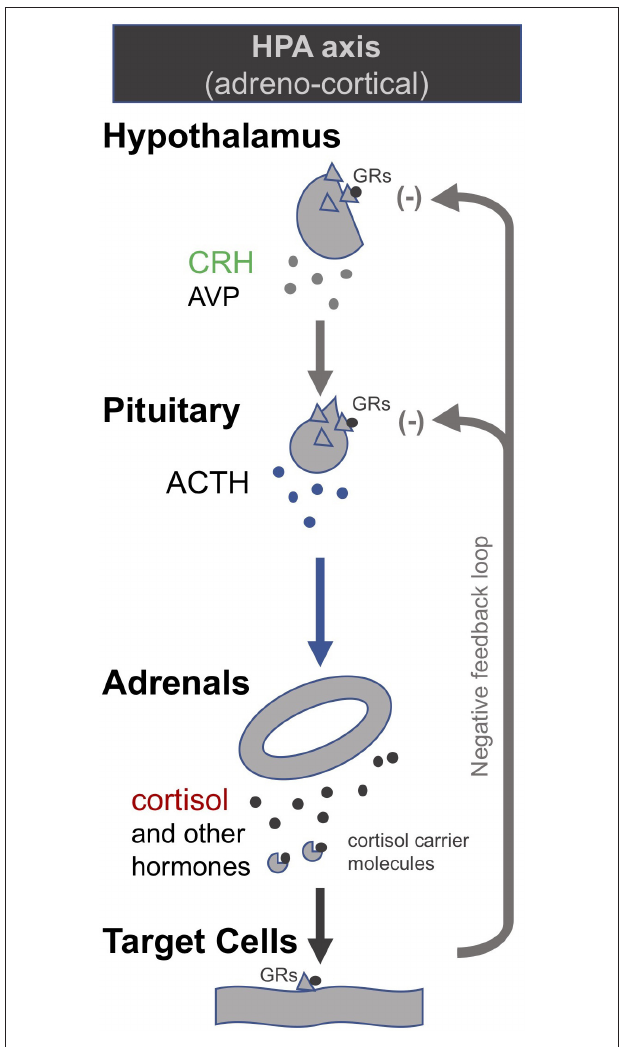
FIGURE 1 | The adreno-cortical axis (HPA axis) [modified from